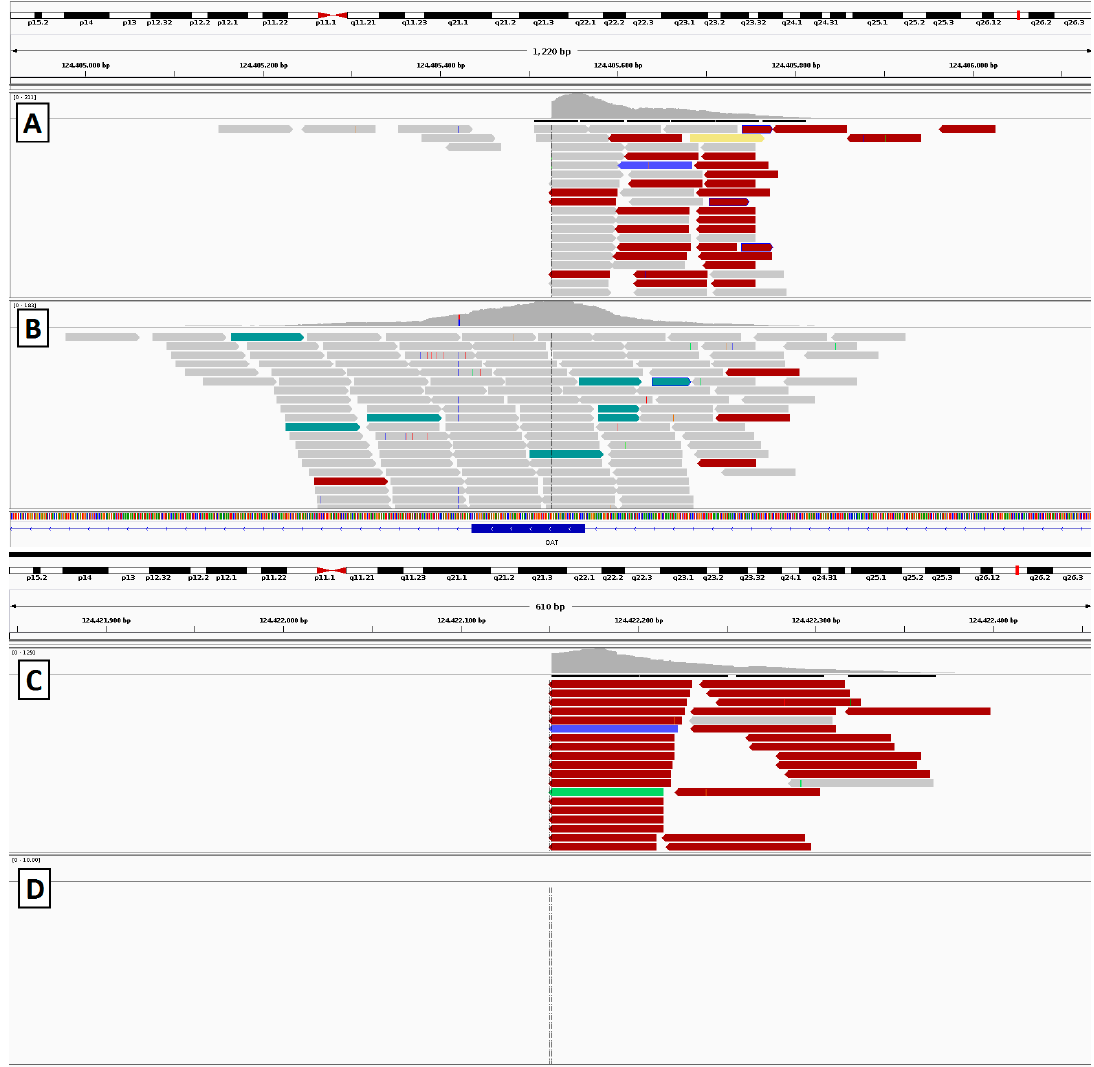
Figure 11. Sequencing results from the gyrate atrophy patient depicting alignment of reads at each breakpoint. ( A , B ) show reads surrounding the exonic breakpoint in the affected patient ( A ) and an unaffected control ( B ). ( C , D ) show the distal breakpoint. This region is not covered by our capture panel, but in the affected patient sample ( C ) alignments can be seen from library fragments that span the inversion breakpoint. In the control patient ( D ), no aligned reads are seen, as expected.